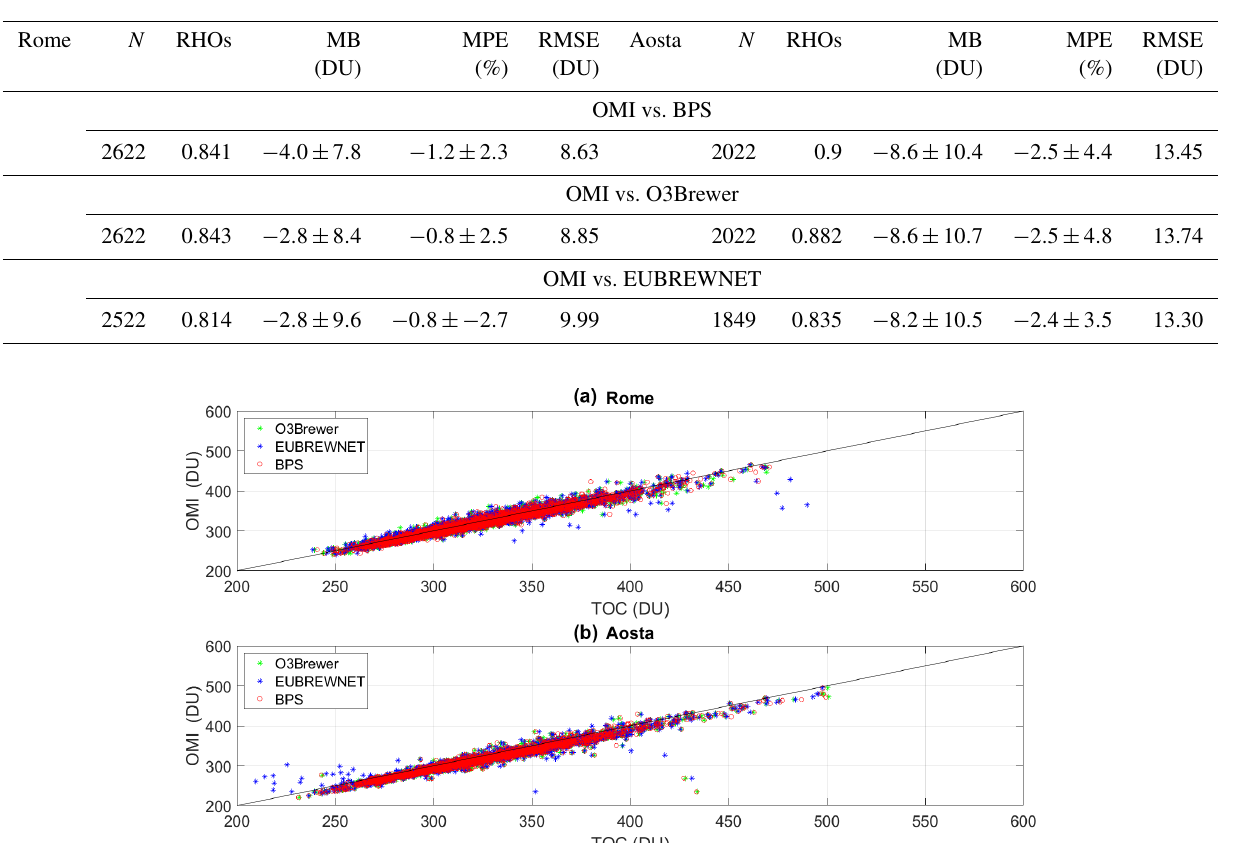
Figure 16. Scatter plots of total ozone column for OMI vs. Brewer at Rome (a) and Aosta (b) . The solid line represents the bisectrix. The comparison is carried out with O3Brewer (green), EUBREWNET (blue) and BPS (red)